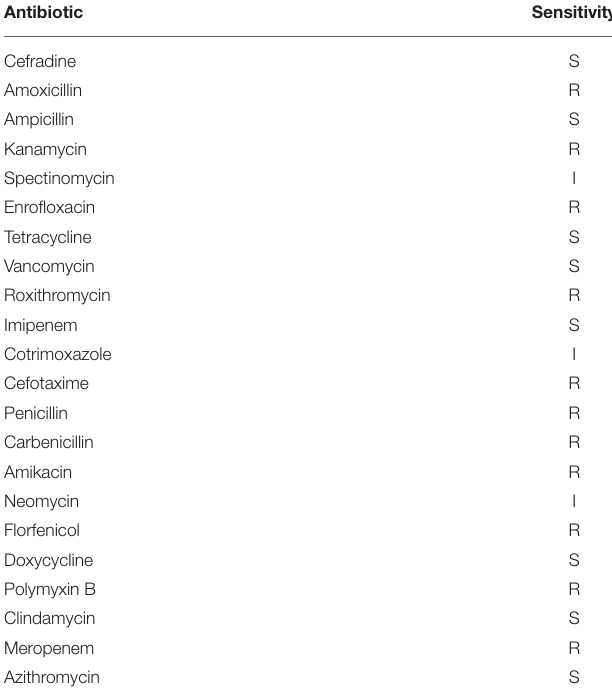
TABLE 2 | Antibiotic susceptibility of strain HT. Antibiotic Sensitivity